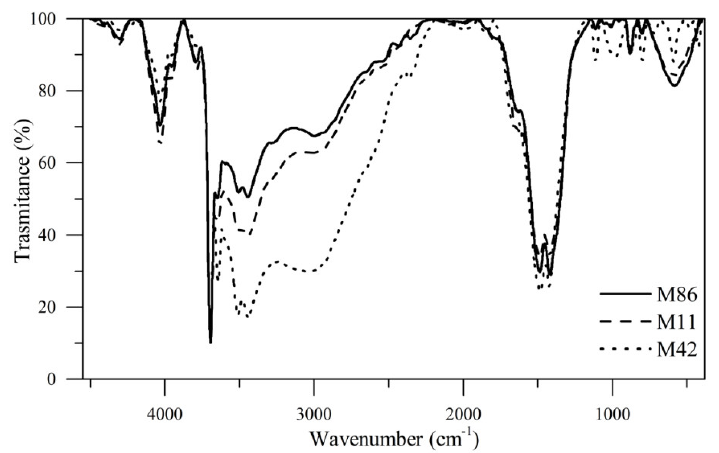
Figure 5. FTIR spectra of the three different sizes of MgO nanoparticles 11 (M11), 42 (M42), and 86 nm (M86) at 25 °C.